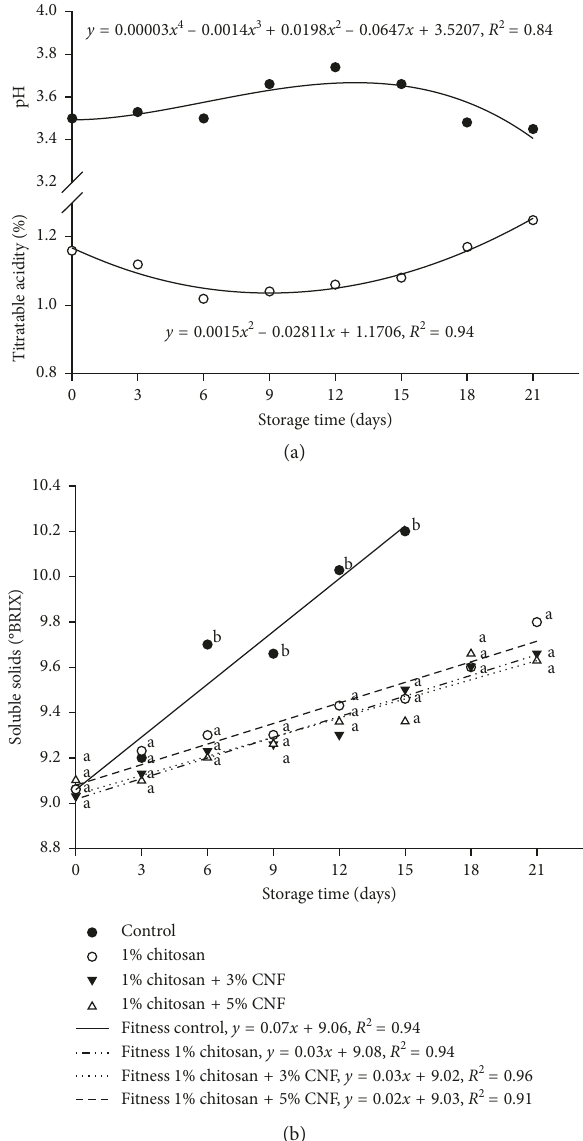
Figure 4: Average values of pH, titratable acidity, and soluble solids of strawberries throughout 21 days of storage. Same letters in the same storage time denote that averages do not differ by the Tukey test at 5% significance